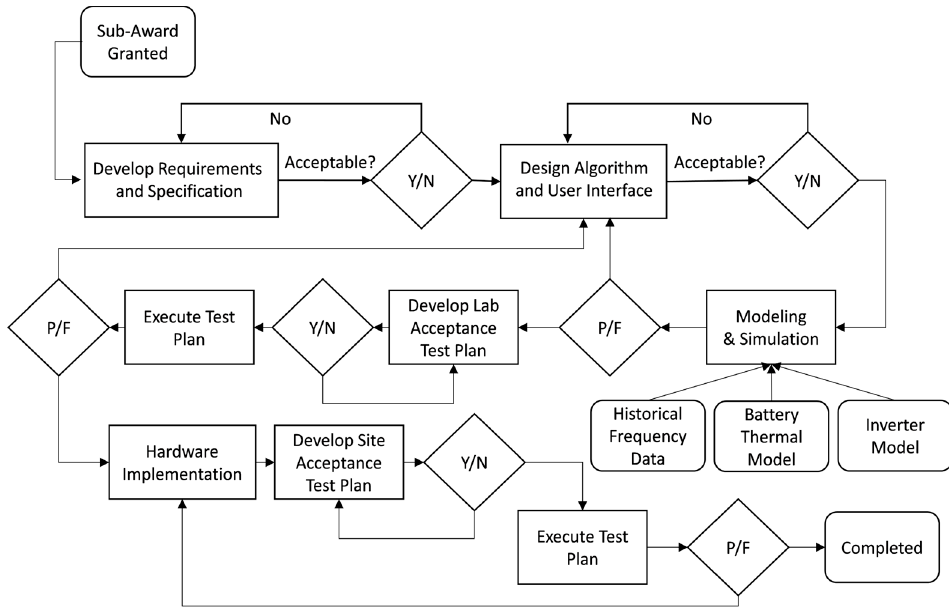
Figure 3. Flowchart of the development process for the frequency response control algorithm.